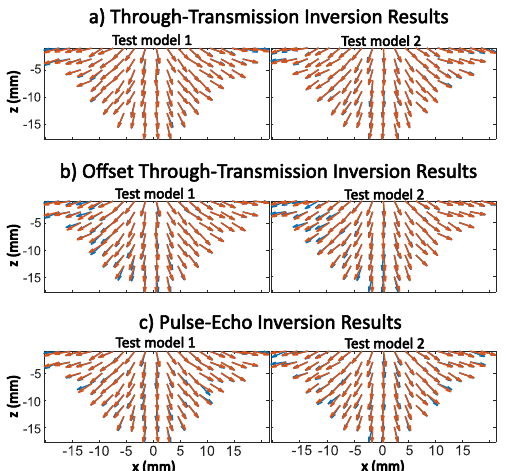
Figure 6. The predicted grain orientations (tomographic reconstructions) from the DNN inversion (red) compared against the true grain orientations (blue) that were used to generate the ToF data, for two test models (not part of the training data). Predictions are shown for ( a ) the through-transmission, ( b ) offset through-transmission, and ( c ) pulse-echo transducer array